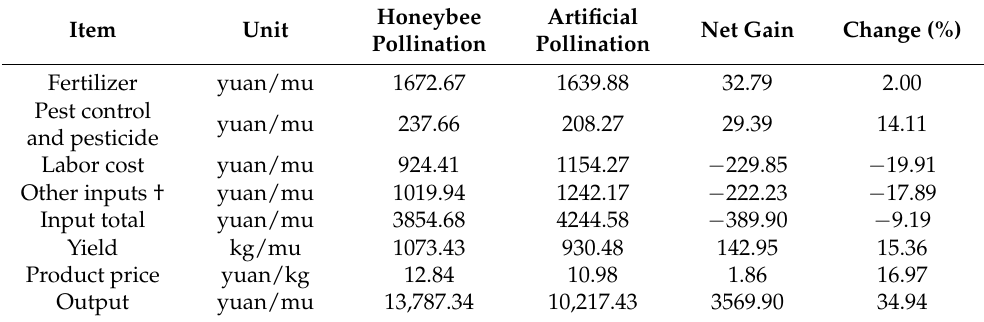
Table 2. Comparison of the production costs and production efficiencies of both pollination technologies.